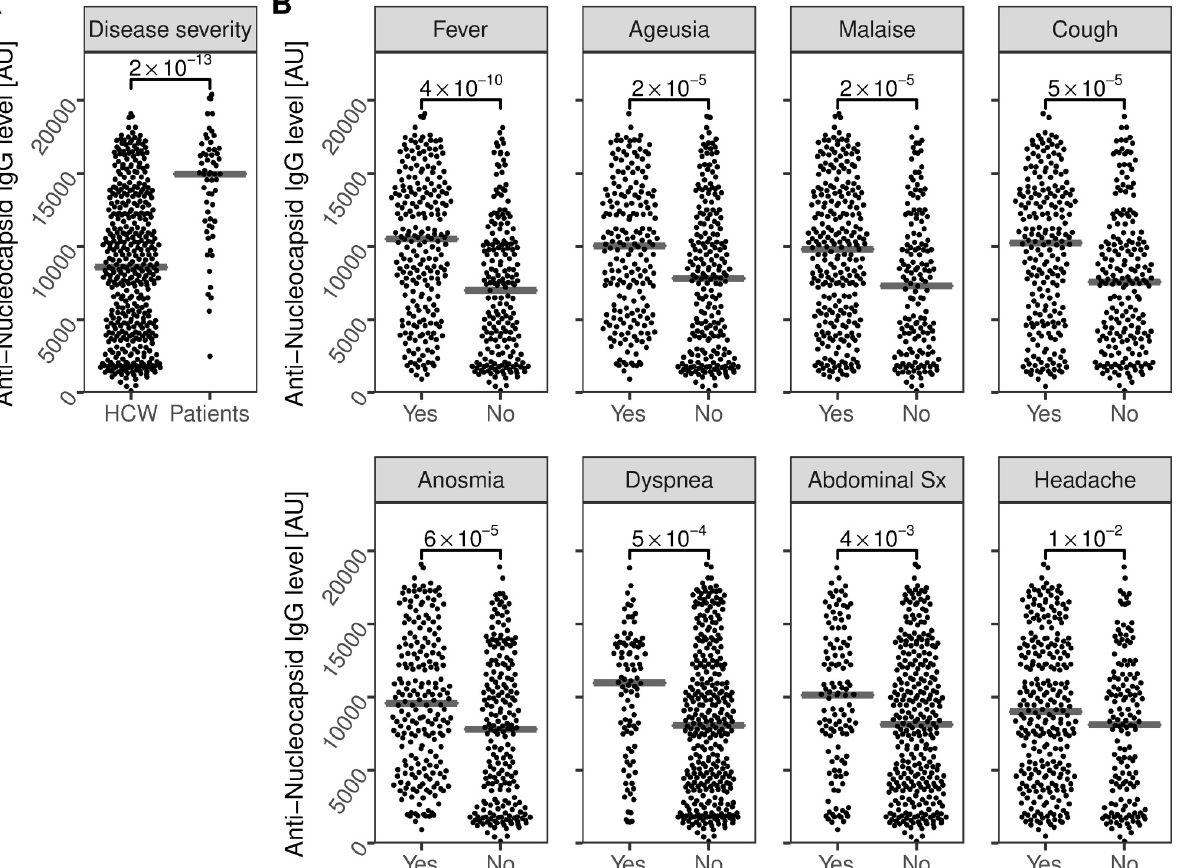
Fig 2. Four-month follow-up levels of anti-nucleocapsid IgG are associated to disease severity and to COVID-19 symptoms. A) Four-month follow-up levels of anti-nucleocapsid IgG were significantly higher in convalescent patients compared to HCW. B) In addition, four-month follow-up levels were significantly increased in HCW with self-reported fever, ageusia, malaise, cough, anosmia, dyspnea, abdominal symptoms, or headache prior to study inclusion. Crossbars depict the median. P-values are shown with brackets. Sx; symptoms. AU: Arbitrary Units.